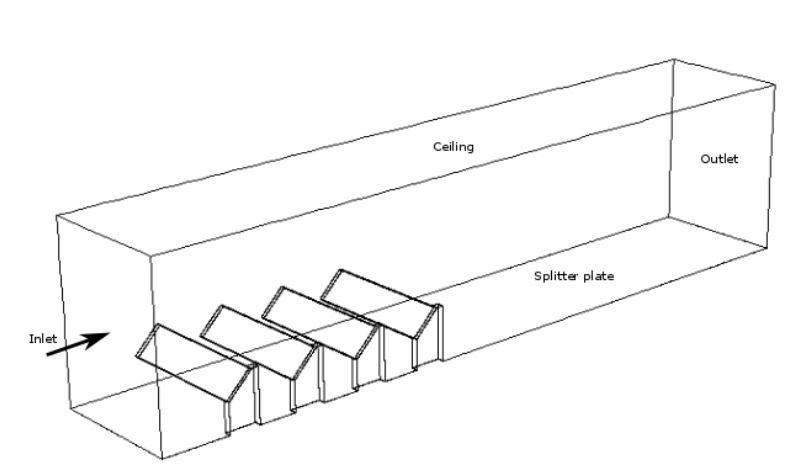
Figure 3. Computational